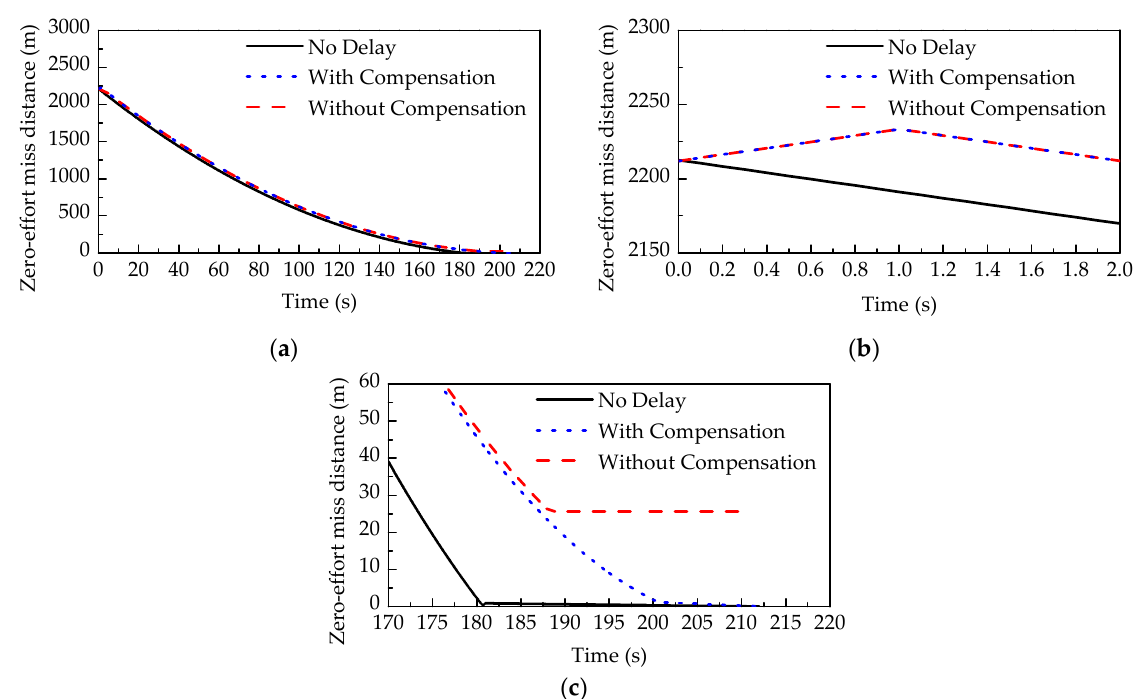
Figure 11. The average ZEM distance of 100 Monte Carlo runs: ( a ) the ZEM distance changing with time; zoom in on the curve at ( b ) the beginning of the confrontation and ( c ) the end of the confrontation.